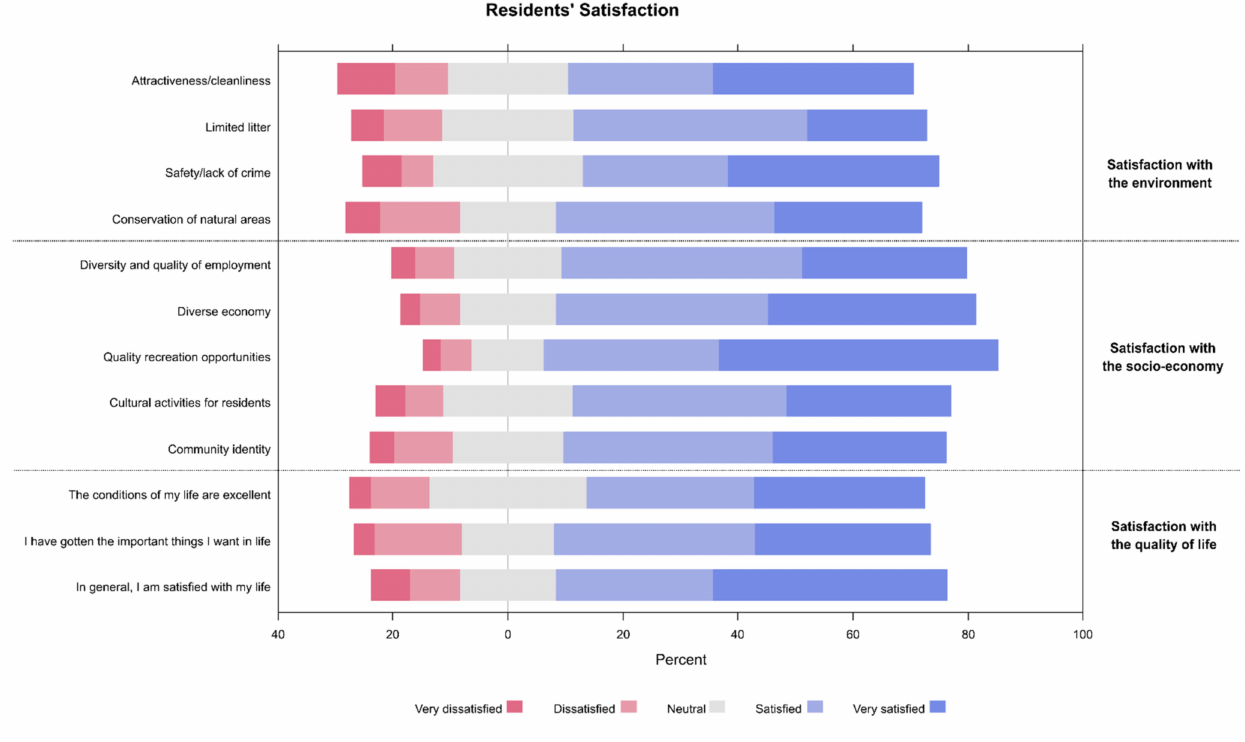
Figure 3. Participant’s responses regarding the different subdomains of